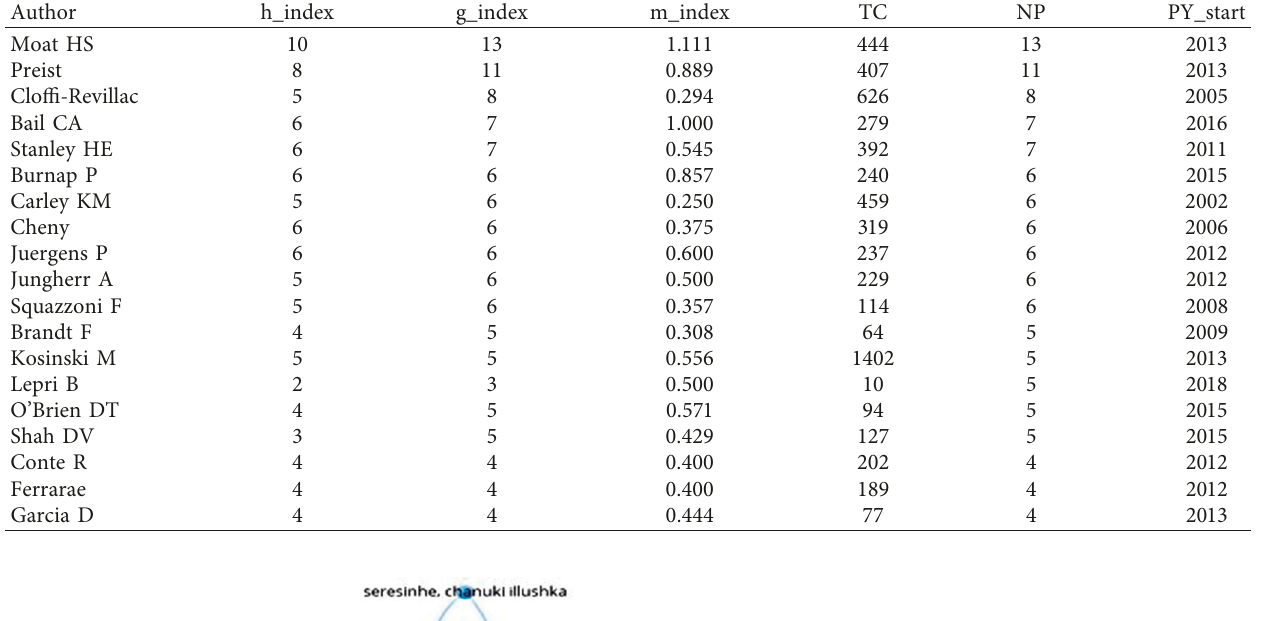
Table 2: Top 20 authors with significant impact in computational social